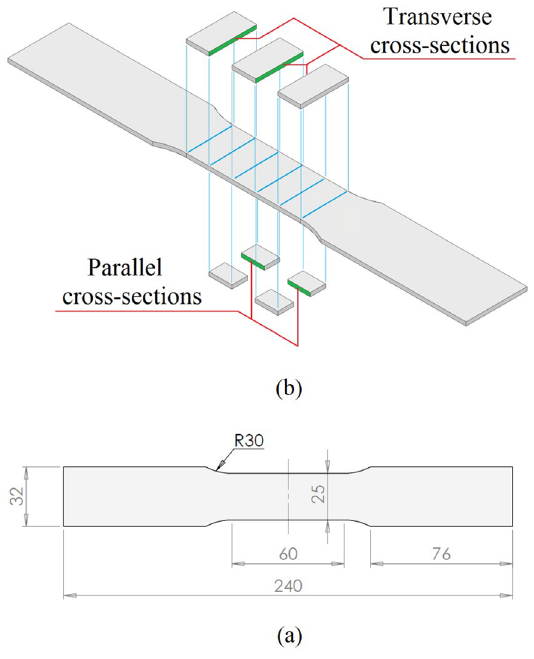
Figure 1. Uniaxial tensile test specimen according to JIS standard: (a) geometry and dimensions and (b) schematic view indicating the cross-sections used in the microvoid and XRD